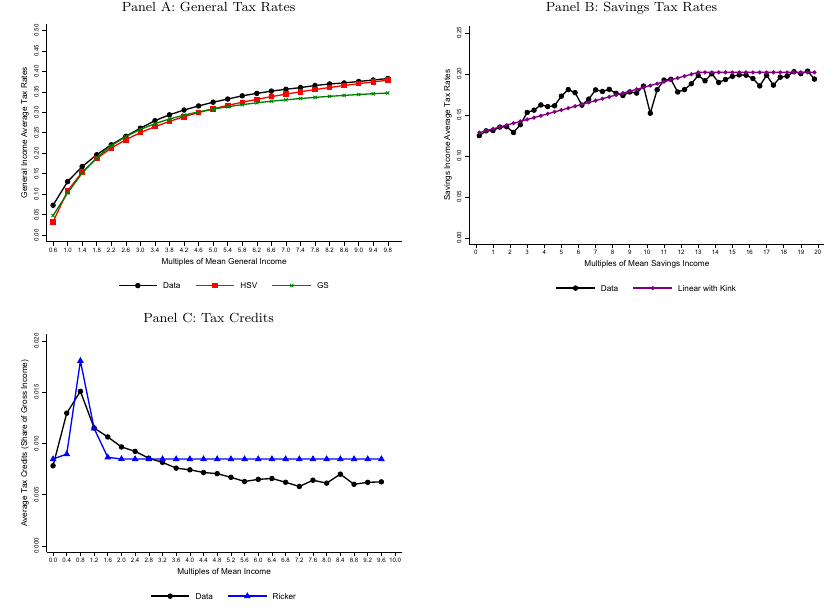
Fig. 6 Parametric functions: three-function approach (individuals 2015)